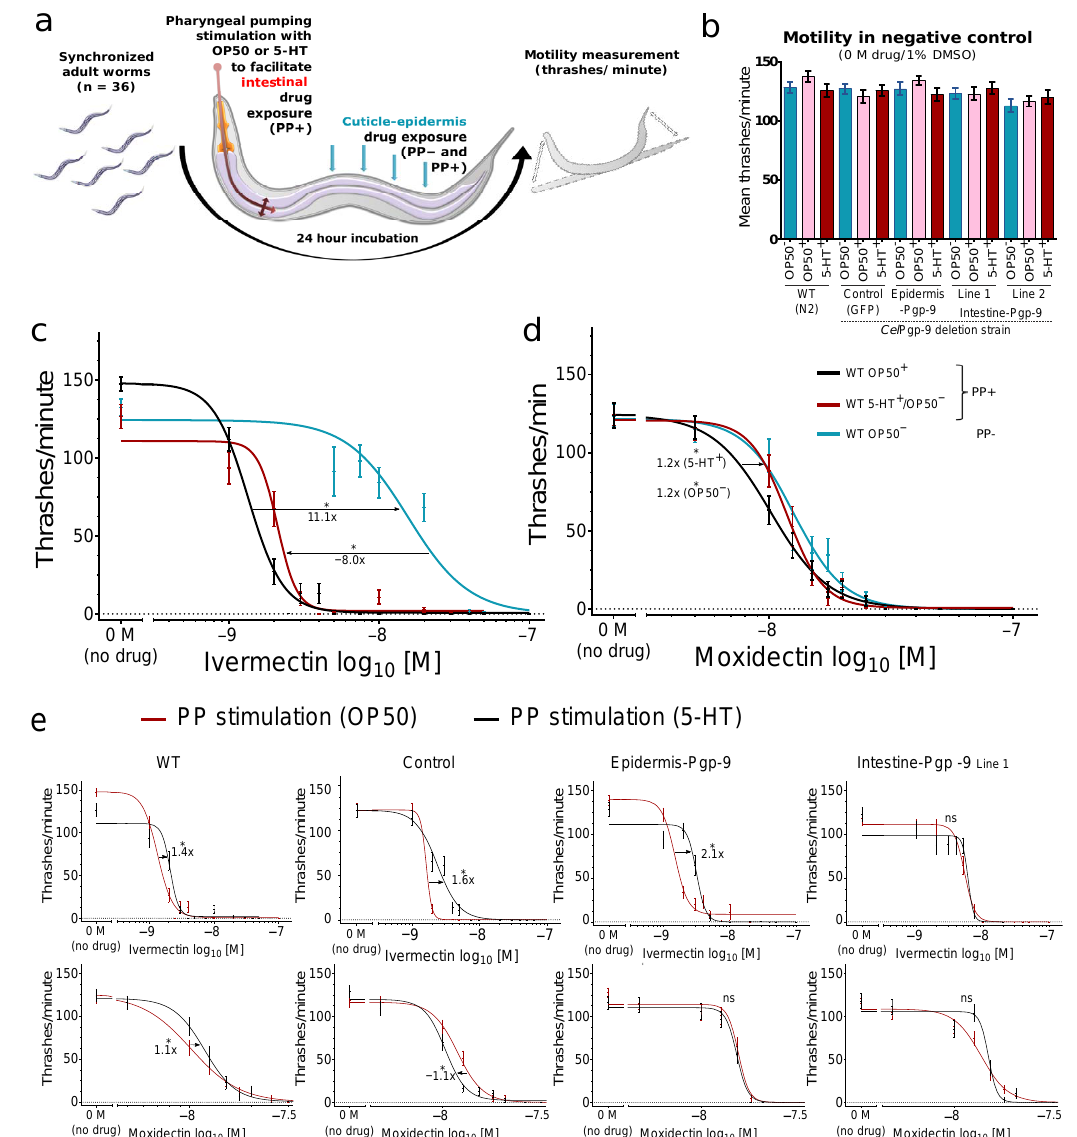
Figure 2. Pharyngeal pumping increases ivermectin and moxidectin susceptibility. Effect of pharyngeal pumping (PP) stimulation by OP50 food bacteria or serotonin in Caenorhabditis elegans on ivermectin and moxidectin susceptibility. ( a ) Schematic illustration of the experimental setup with active ingestion and intestine drug exposure by PP stimulation. ( b ) Mean thrashes/minute ± standard error of the mean (SEM) in the negative control (no drug, 1% DMSO) between strains and conditions. Each strain/condition combination was compared to WT OP50 − with a Kruskal–Wallis test with Dunn’s post hoc, and p > 0.05 was considered not significant. ( c , d ) Ivermectin and moxidectin concentration–response curves calculated with GraphPad v8.3.0 based on thrashes/minute in the WT strain with n = 36 per concentration spread equally on three separate days. PP stimulation by OP50 bacteria (OP50 + ) (black), 4 mM 5-HT (red), or in the absence of a PP stimulus (OP50 − ) (blue). Significant differences between half-maximal effective concentration (EC 50 ) were calculated using the extra-sum-of-squares-F test and Bonferroni correction. ( e ) Comparison of the effect of PP stimulation by OP50 Escherichia coli food bacteria (red) or 5-HT (black) in different transgenic and wildtype strains. ( c – e ) All calculated four parameter non-linear regression models and SEM at each concentration correspond to Supplementary Tables S1 and S2. Prior to the calculation, the no-drug negative control was set to 0.1 nM and all concentrations were log 10 transformed. On the x-axis, the negative control was visualised as “0 M (no drug)” and separated by a break in the axis. P -values < 0.05 were considered significant and are indicated with an asterisk, while corresponding fold-changes are indicated with arrows. 5-HT: serotonin/5-hydroxytryptamine; WT: C. elegans N2 Bristol; Control strain genotype CtrlEx1 [ Cel-pgp-9(-); Cel-myo-2p::gfp:: Cel-unc-54_3 (cid:48) -UTR